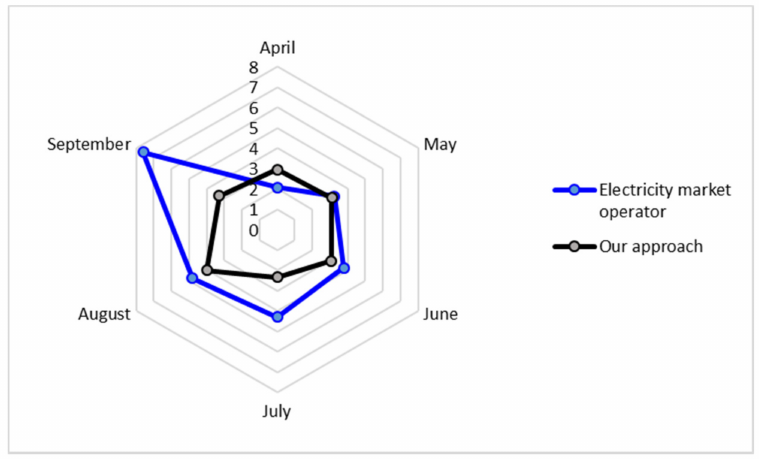
Figure 8. Performance comparison of the model used by the Atl á ntico electricity market operator and the proposed